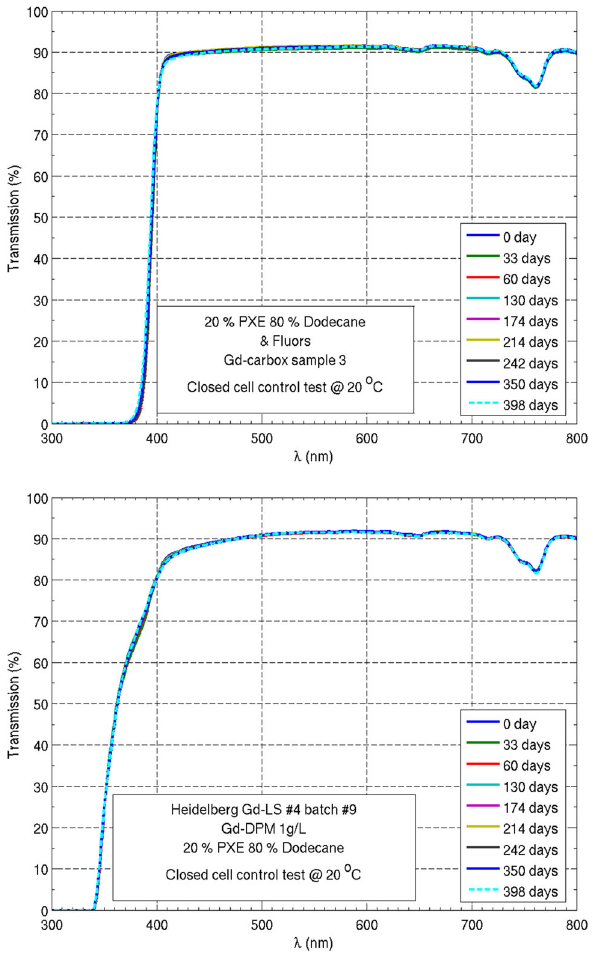
Fig. 8 Light transmission ( T ) of Gd doped liquid scintillators. A Gd- CBX (top) and a Gd-BDK (bottom) prototype sample are shown, both stored at 20 ◦